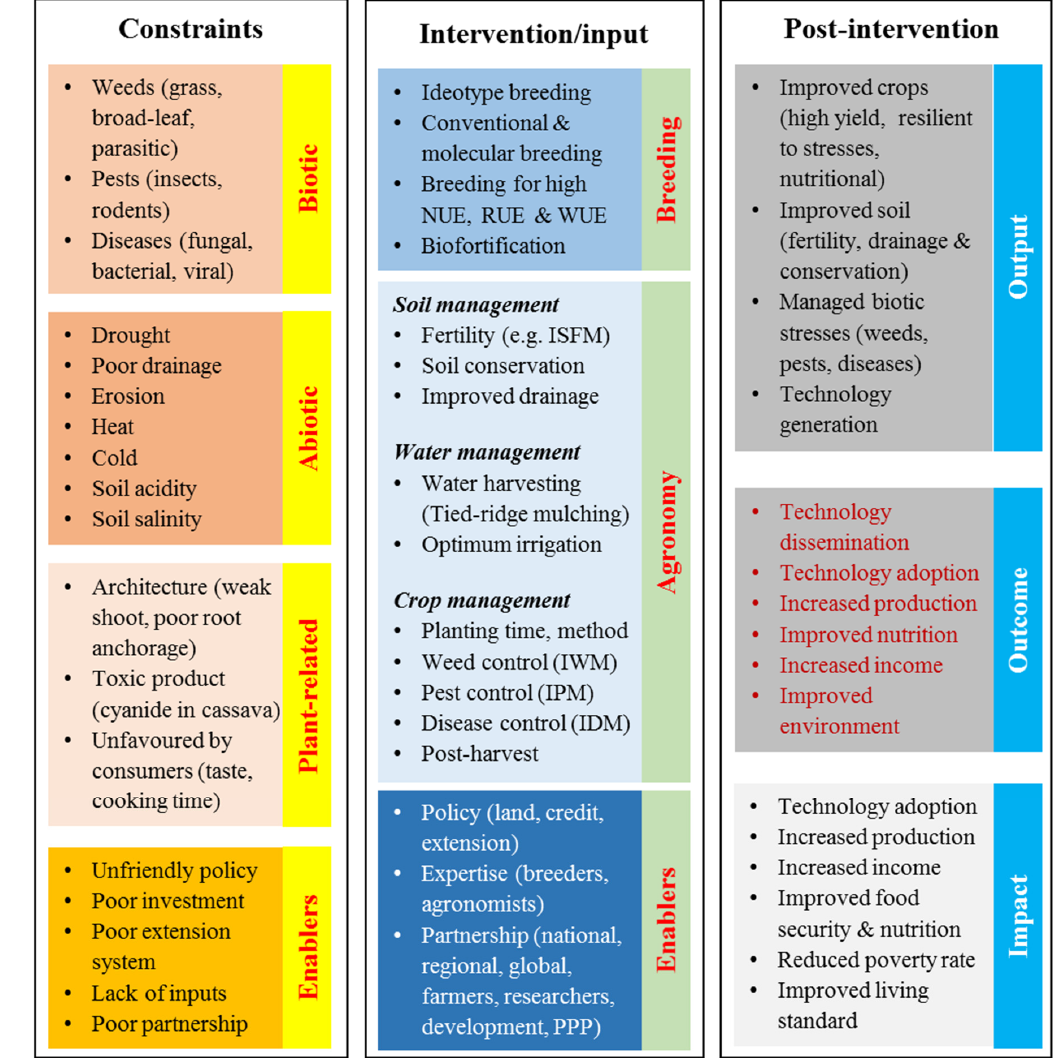
Figure 5. Diverse types of constraints facing African farmers and possible ways of interventions as well as expectations (outputs, outcomes and impact) from interventions. IDM: integrated disease management; IPM: integrated pest management; ISFM: integrated soil fertility management; IWM: integrated weed management; NUE: nutrient ‐ use efficiency; PPP: public ‐ private partnership; RUE: radiation ‐ use efficiency; WUE: water ‐ use efficiency.